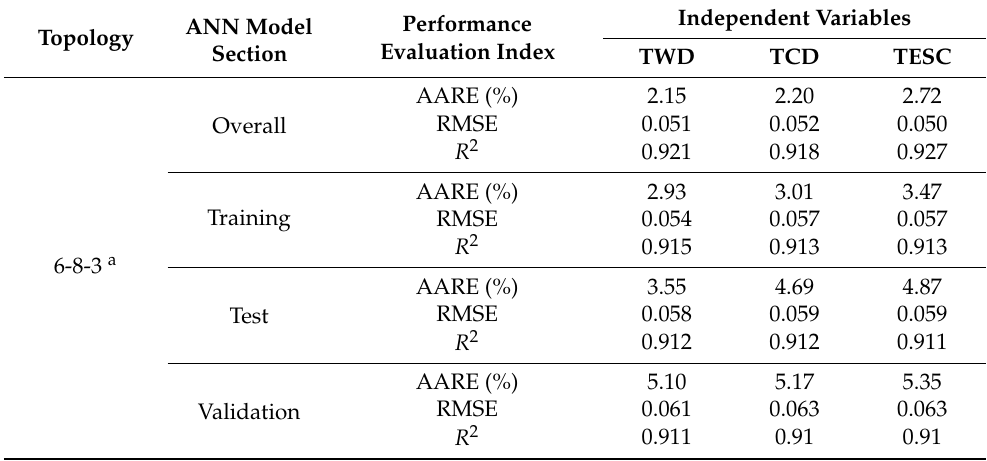
Table 7. The results of ANN modeling for mushroom production.